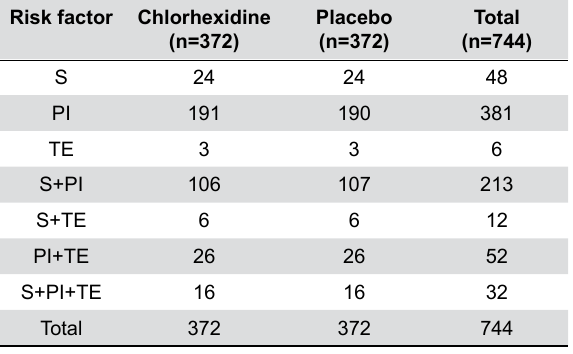
Table 2- Frequency of patients by matched risk factors for alveolar osteitis, distributed by treatment group